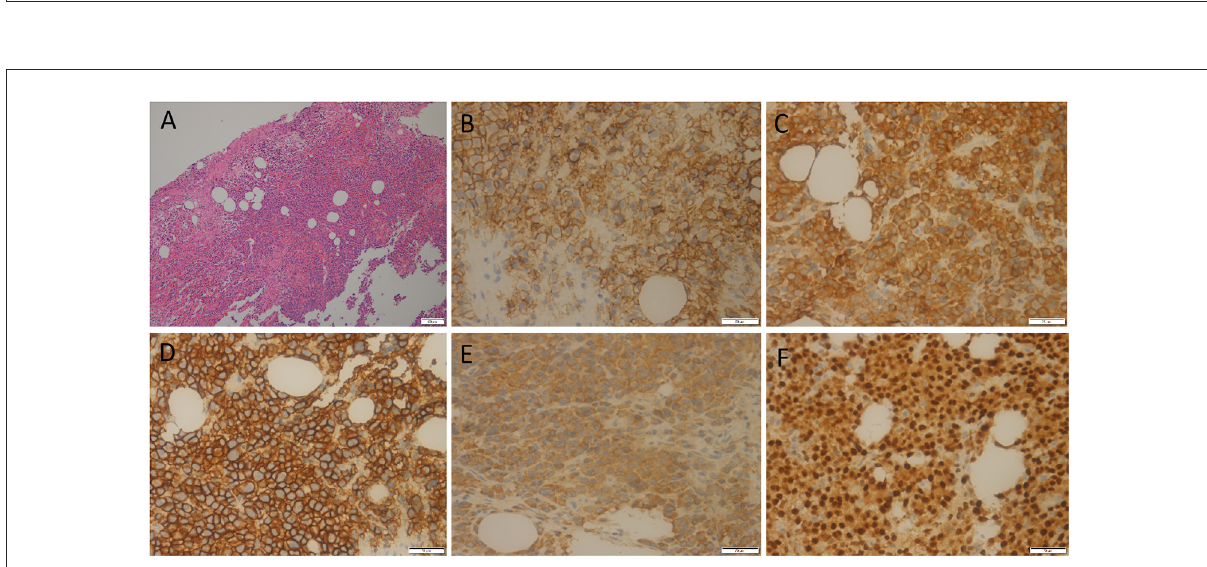
FIGURE3 HE staining showed the diffuse distribution of round or oval plasma cells in the tumor (A) . Immunohistochemistry showed positive expression of tumor cells CD56 (B) , CD79a (C) , CD138 (D) , Kappa (E) , and MUM1 (F)